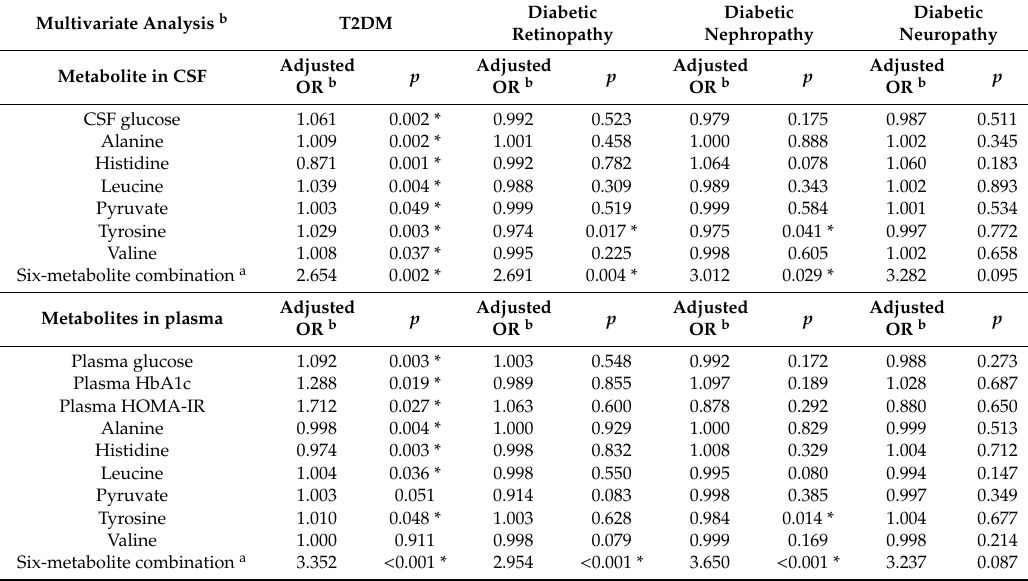
Table 7. Association of metabolites in six-metabolite combination with the presence of T2DM and diabetic